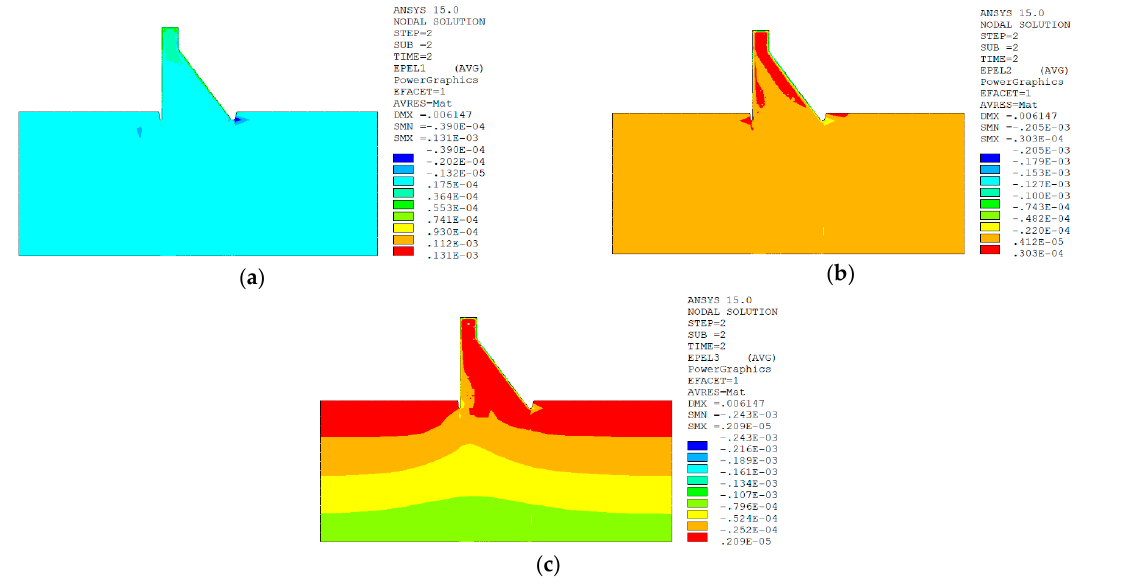
Figure 22. The cloud charts of the three principal strains on the section z = 21 m are calculated by the macro-meso model under the temperature rise condition, ( a ) The cloud chart of the first prin- cipal strain, ( b ) The cloud chart of the second principal strain, ( c ) The cloud chart of the third prin- cipal strain.